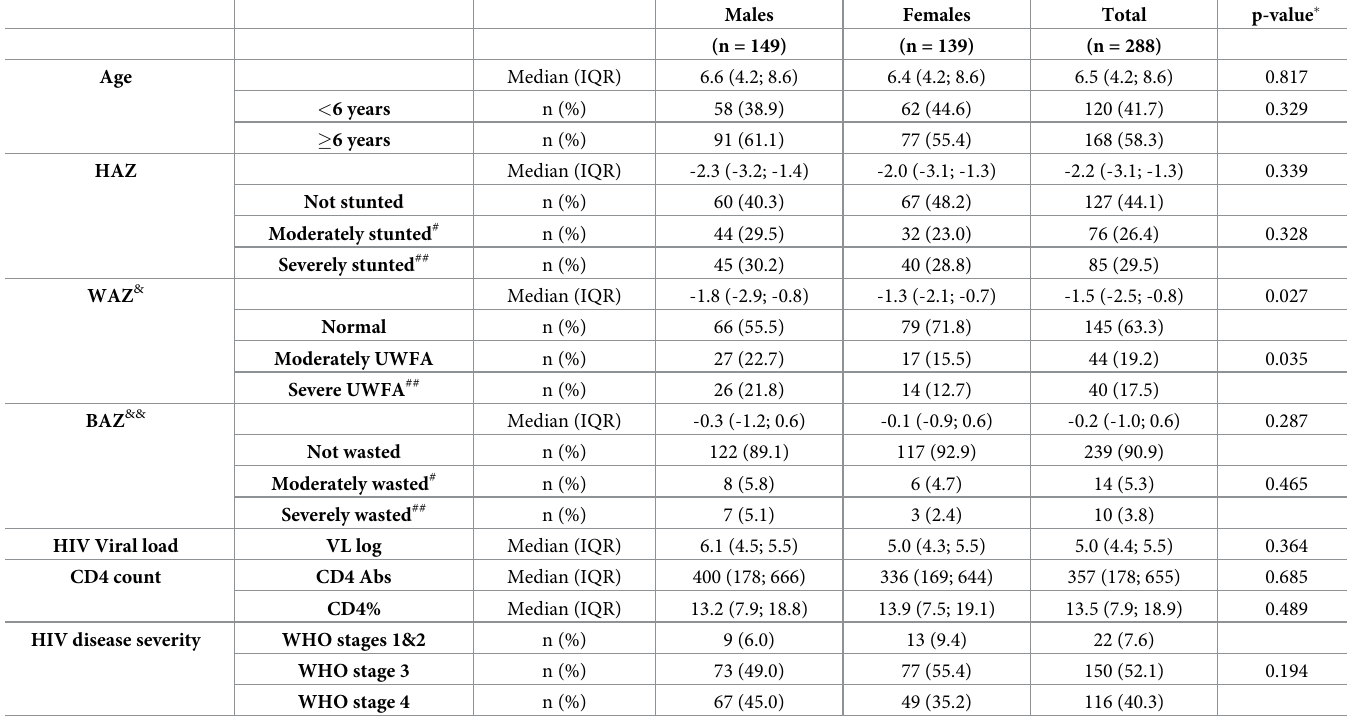
Table 1. Baseline characteristics, at initiation of antiretroviral therapy, of the children living with perinatally-acquired HIV